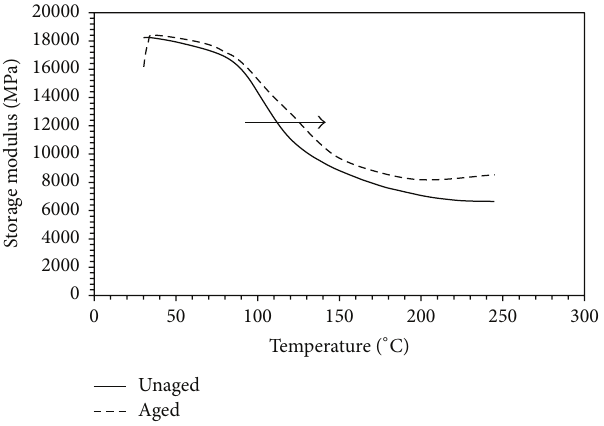
Figure 6: Viscoelastic trend of storage modulus before and after 800 h oxidative aging at 82 ∘ C.